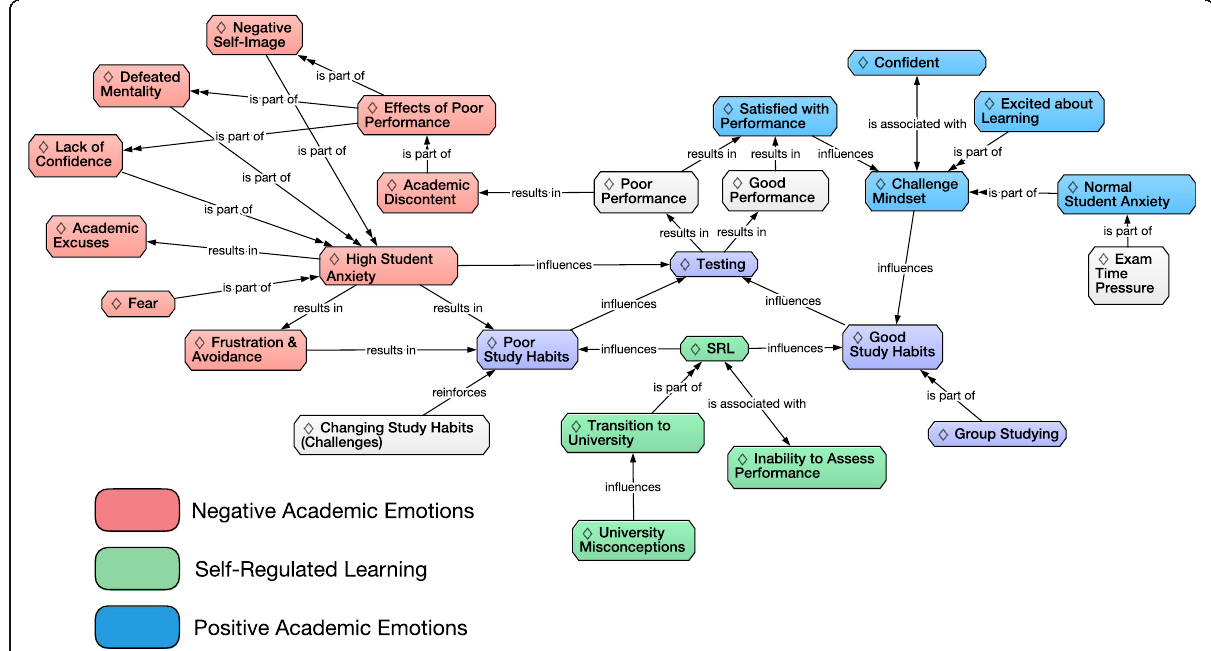
Fig. 1 Emergent model representing the data analyzed in this study. Lines connecting and the category labels represent the interpreted semantic relationships between the linked